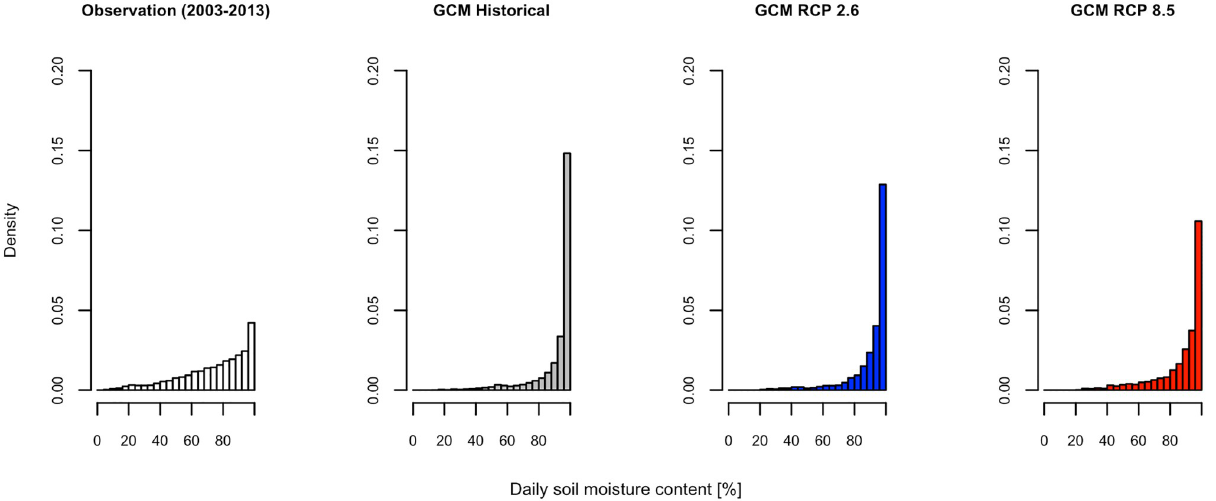
Fig 5. Differences in the soil moisture content among observed and MIROC (a global climate model) data.